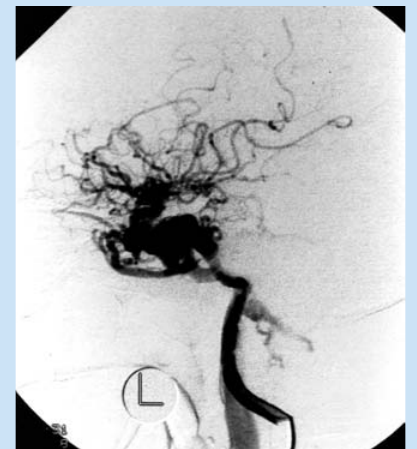
Fig. 2a. Lateral internal carotid angiogram showing direct